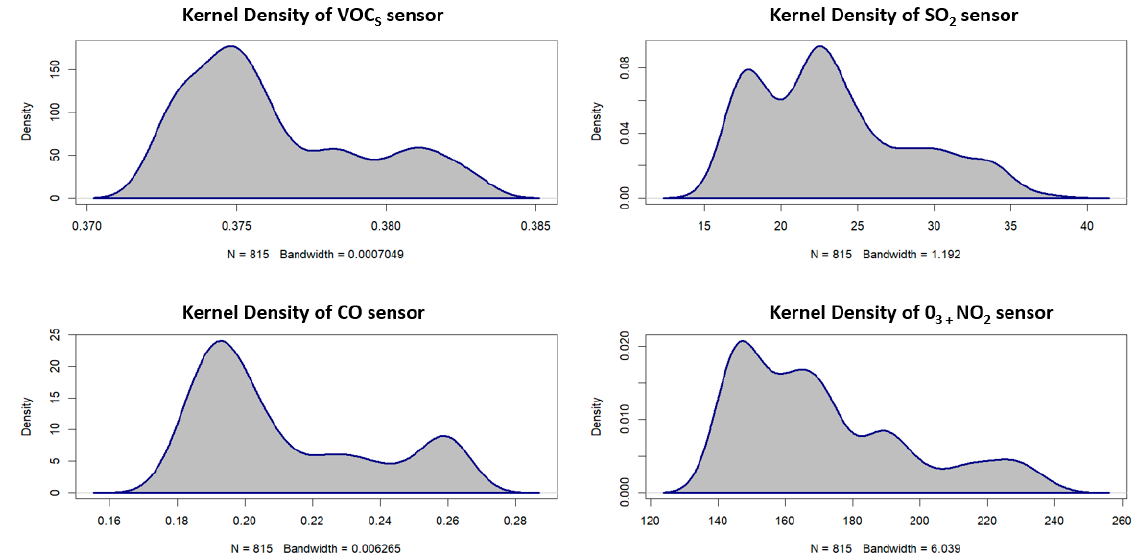
Figure A6. Kernel density for second ground measurement (H 2 S sensor, HCL sensor).